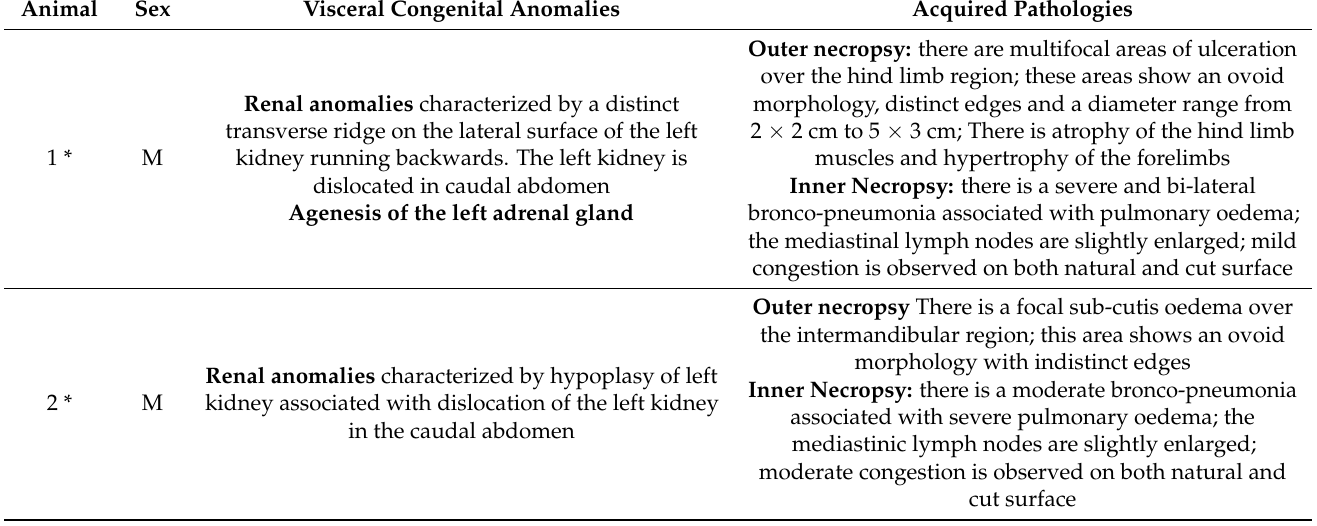
Figure 6. Representative pathological alterations in perosomus elumbis cases. ( A ) External appearance of perosomus elumbis, ( B ) hindlimbs dysplasia and multifocal ulcerations on hindlimbs region, ( C ) atrophy of the hind limb muscles, ( D ) lumbar vertebra shows normal development of the vertebral canal, ( E ) lumbar vertebra shows agenesis of vertebral canal, ( F ) renal hypoplasia, ( G , H ) renal anomalies characterized by a distinct transverse ridge on the lateral surface of the kidney running backwards (arrows), ( I ) severe and bi-lateral bronco-pneumonia. Scale bar, 2 cm. Table 2. Visceral congenital anomalies and acquired pathologies of the assessed animals. * first-birth animals ** second- birth